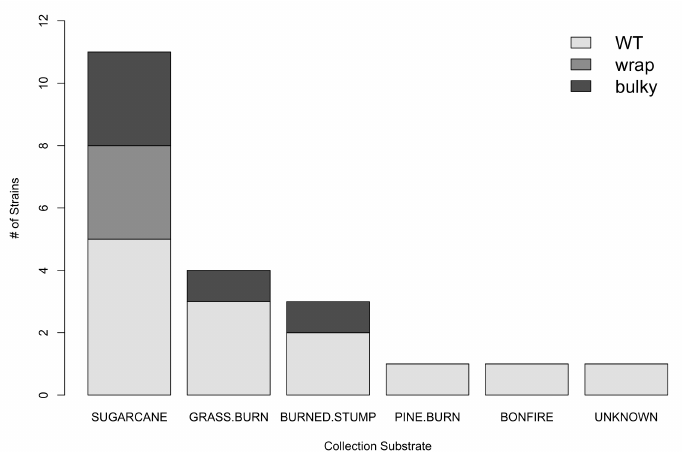
Figure 3. There is no significant correlation between the substrate from which a strain was collected and its most prominent phenotype (X 2 = 4.9196, df = 10, p = 0.8965) from Table 1. Collection substrate as reported by the Fungal Genetics Stock Center (FGSC).